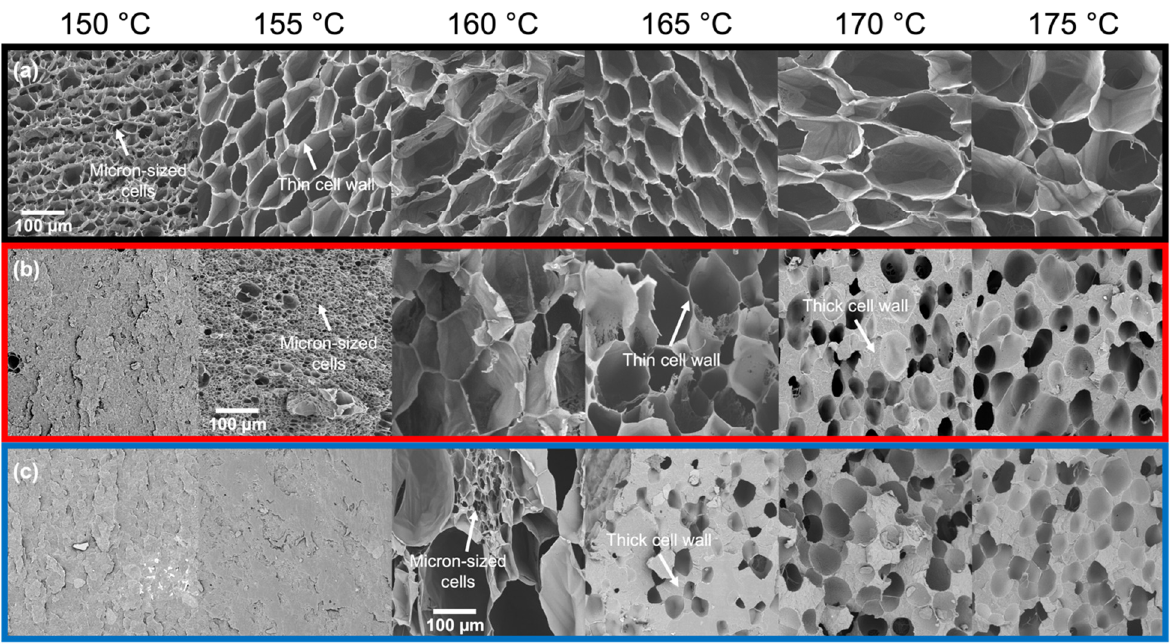
Figure 6. SEM images of ( a ) Resin A, ( b ) Resin B, and ( c ) Resin C foams produced using Method 1 (i.e., partial melting of PP). End melting temperatures of the resins are 154 °C, 159 °C, and 165 °C, respectively.